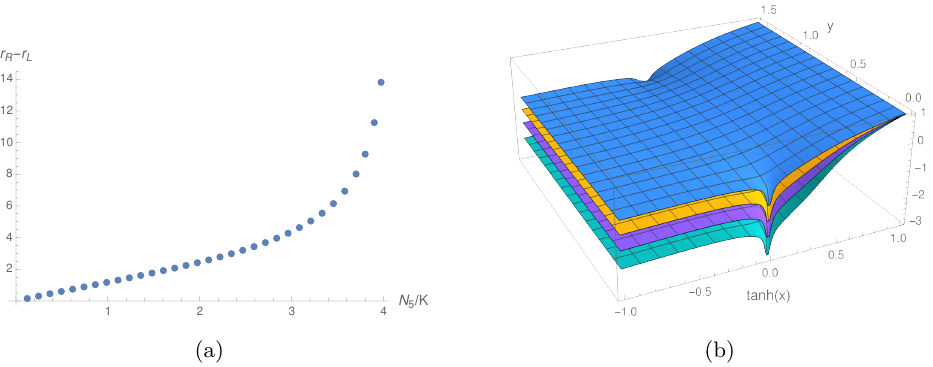
Figure 8 . Left: r R − r L , where r R = lim x → + ∞ r ( x, y ) is the anchor of the minimal surface in the non-gravitating bath and r L = lim x →−∞ r ( x, y ) , as function of N 5 /K at zero temperature. Right: island surfaces, from top to bottom for N 5 /K ∈ { 1 . 2 , 1 . 6 , 2 . 0 , 2 . 4 } . At zero temperature r R − r L is independent of r R